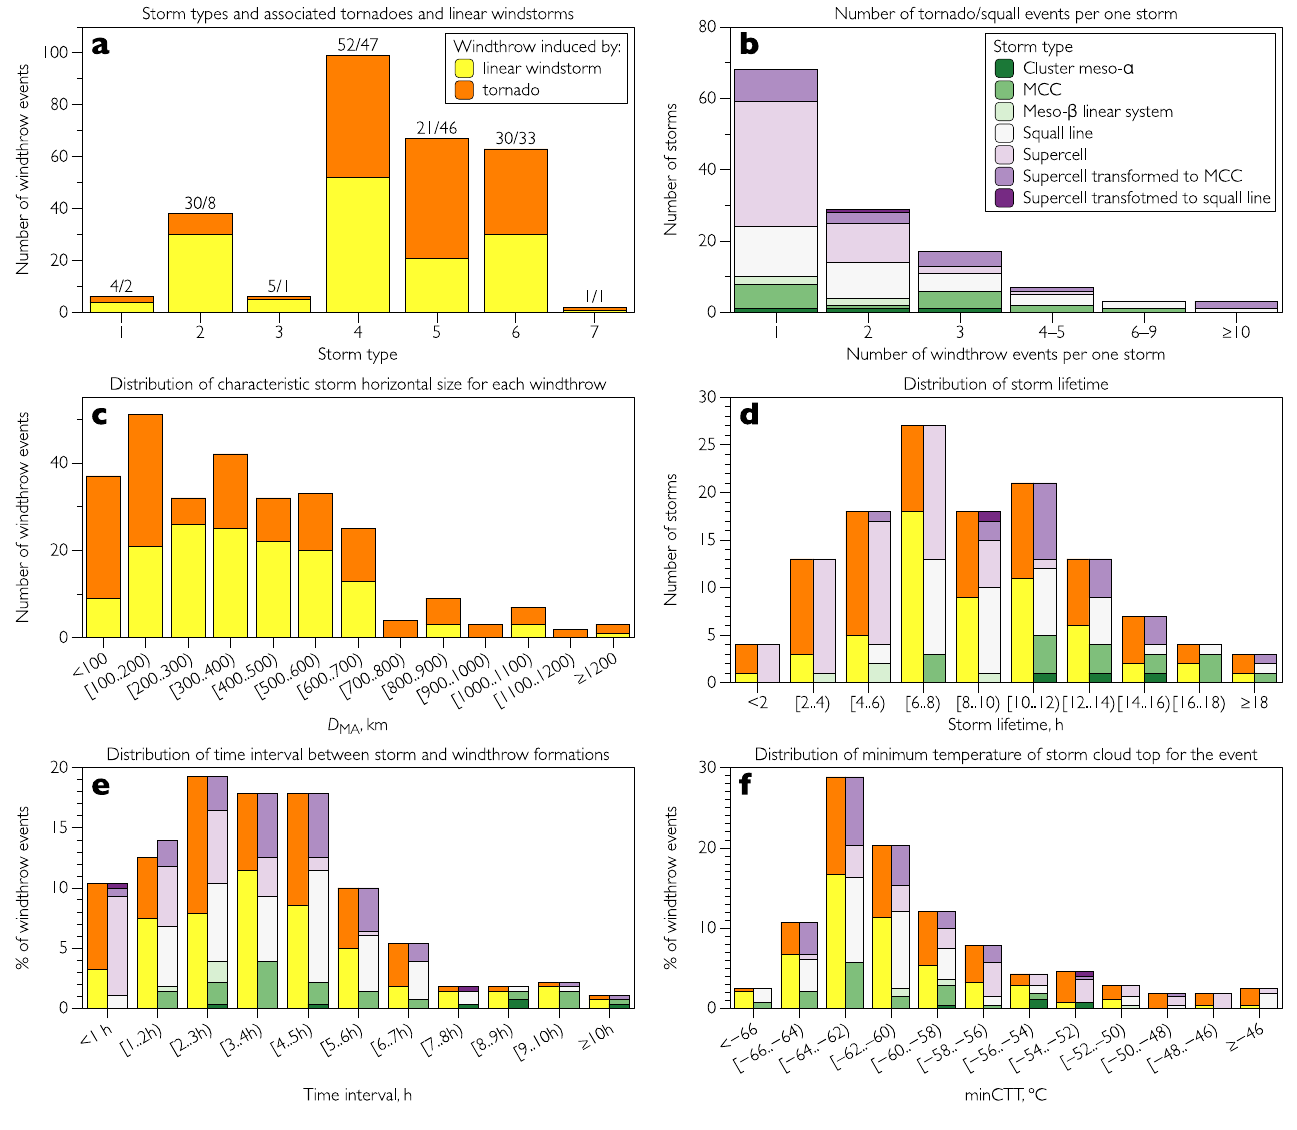
Figure 5. Characteristics of convective storms and related windthrow events: ( a ) a number of windthrow events (induced by linear windstorms or tornadoes; shown as bars and also as numbers over each bar) associated with different types of convective storms: 1—low-organized cluster, 2—MCC, 3—quasi-linear storm (Meso- β ), 4—squall line (quasi-linear storm of meso- α scale), 5—supercell, 6—supercell transformed to MCC, 7—supercell transformed into quasi-linear system; ( b ) a number of windthrow events per storm; ( c ) distribution of windthrow events depending on characteristic horizontal size of corresponding convective storm (major axis diameter, D MA ); ( d ) distribution of convective storms depending on their lifetime (orange and yellow colors stand here for storms with and without tornadoes, respectively); ( e ) distribution of windthrow events depending on the time interval between the formation of the corresponding convective storm and the starting time of the event itself; ( f ) distribution of minimum temperature on the cloud top associated with windthrow events. The sample size equals 281 for windthrow events and 128 for storms.